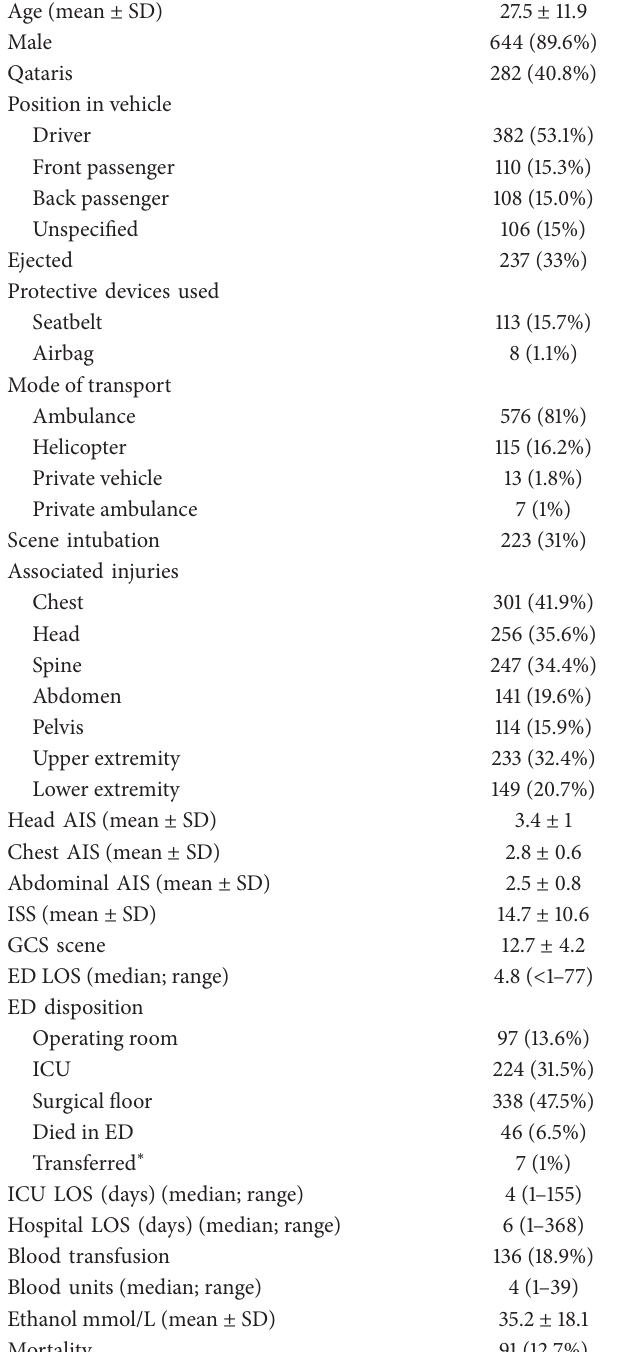
Table 1: Overall analysis of rollover car crashes (ROCs) ( 𝑛 = 719 ).